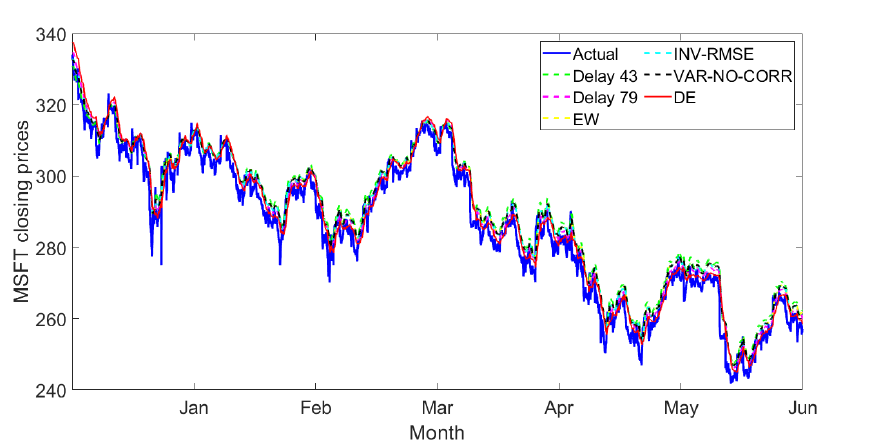
Figure 13. The forecasting curve for actual data versus the individual and combination methods of MSFT stock obtained from CNN model between January and June 2022.